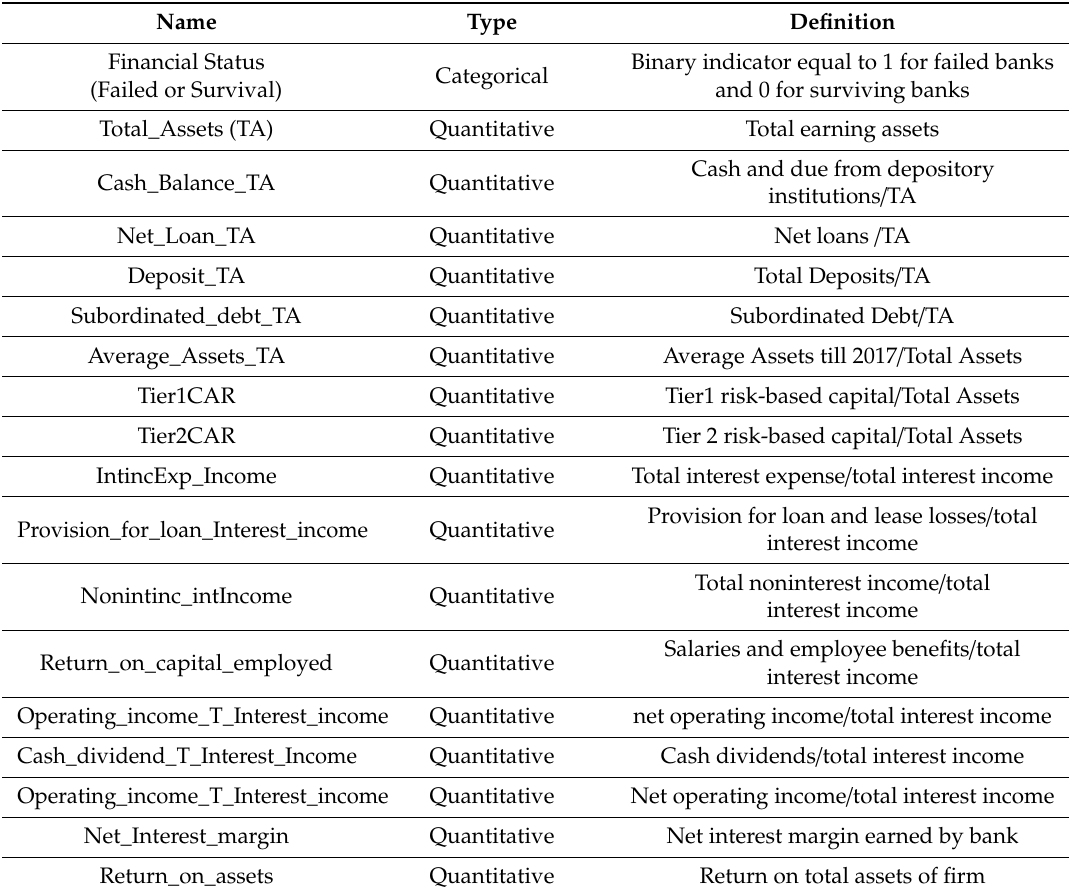
Table A1. List of 25 features calculated for